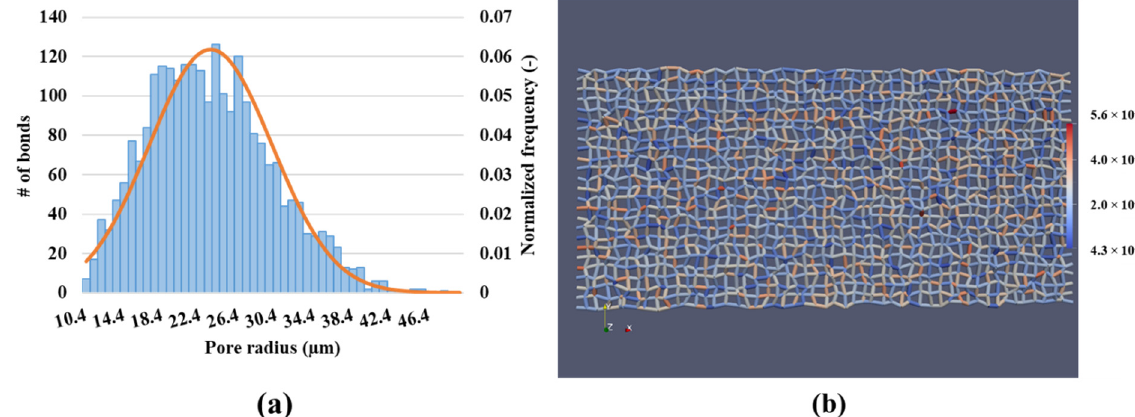
Figure 3. ( a ) pore size distribution, truncated normal distribution, and ( b ) pore network model used in this study.